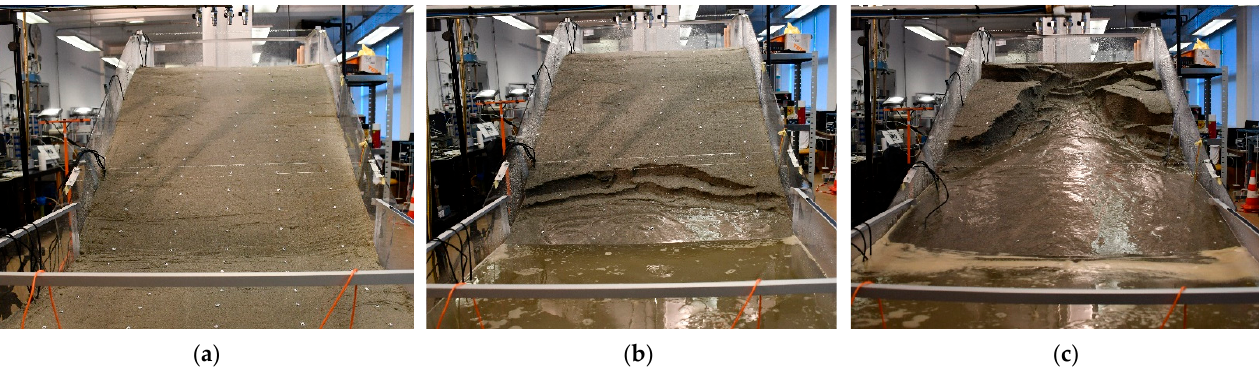
Figure 8. The sandy slope model considered in Example 1 at the beginning of the test ( a ); after 77 min of rainfall simulation ( b ); and at the end of the test ( c ).